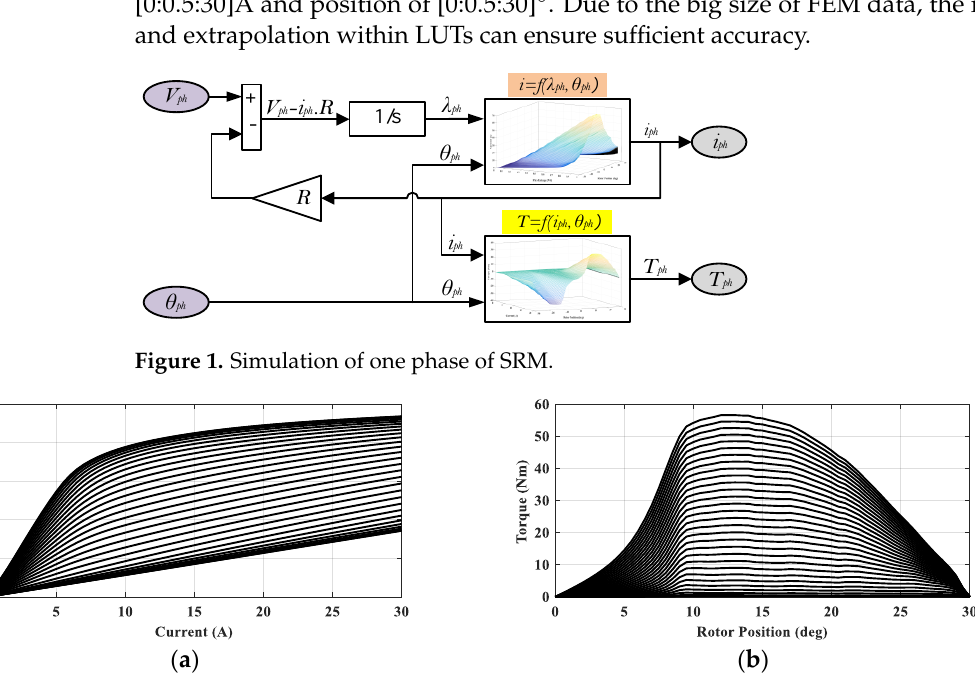
Figure 2. FEM-calculated characteristics: ( a ) flux linkage for [1:1:30]°; ( b ) torque for [1:1:30]A.